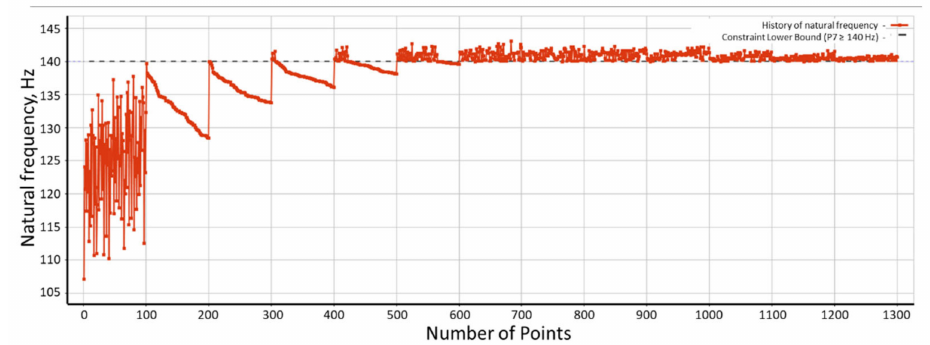
Figure 17. Convergence history for first mode natural frequency.